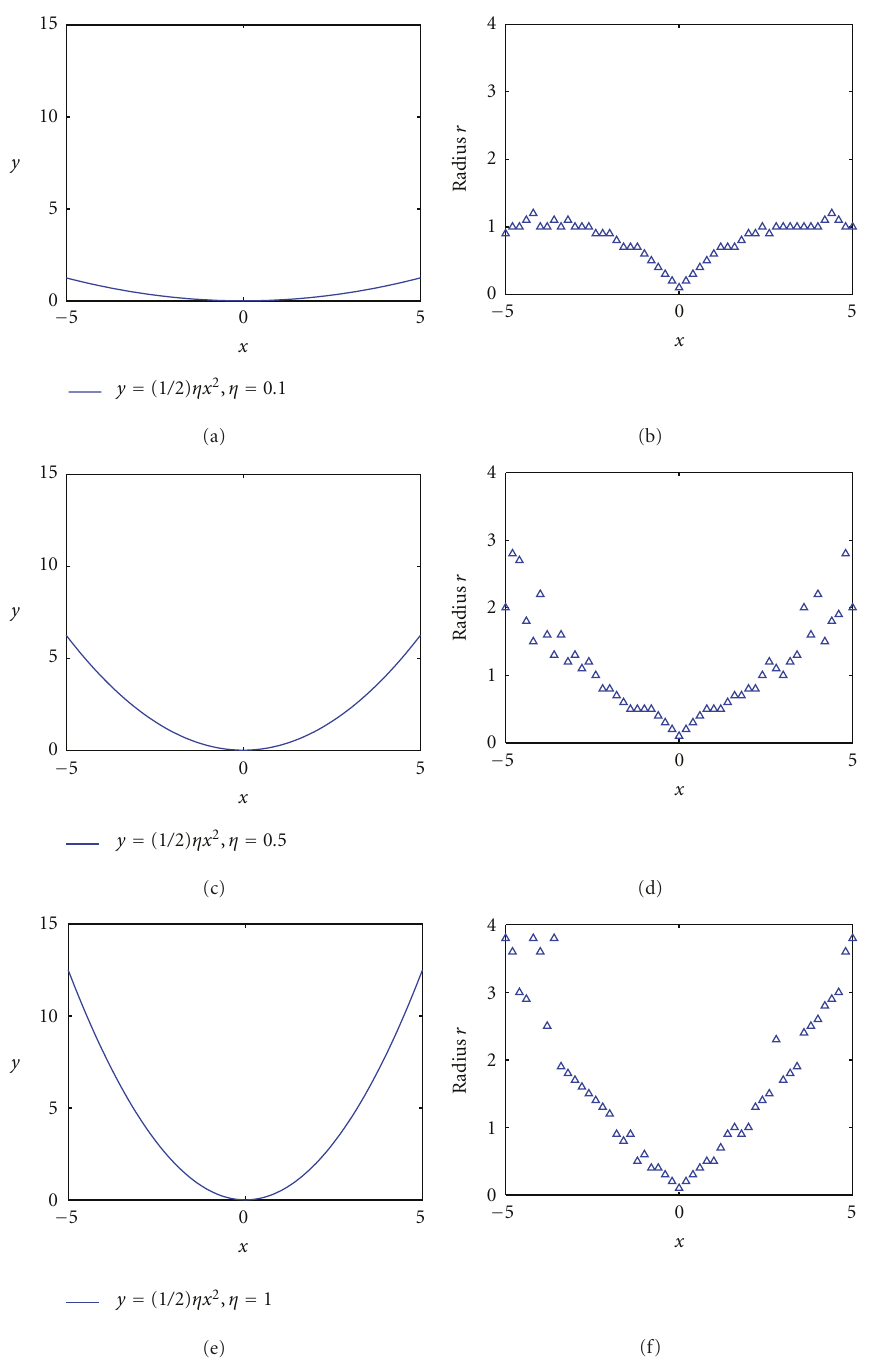
Figure 3: The proposed adaptive curvature estimator is applied to the curves depicted in (a), (c), and (e). The resultant radii of Ω r are shown in (b), (d), and (f),